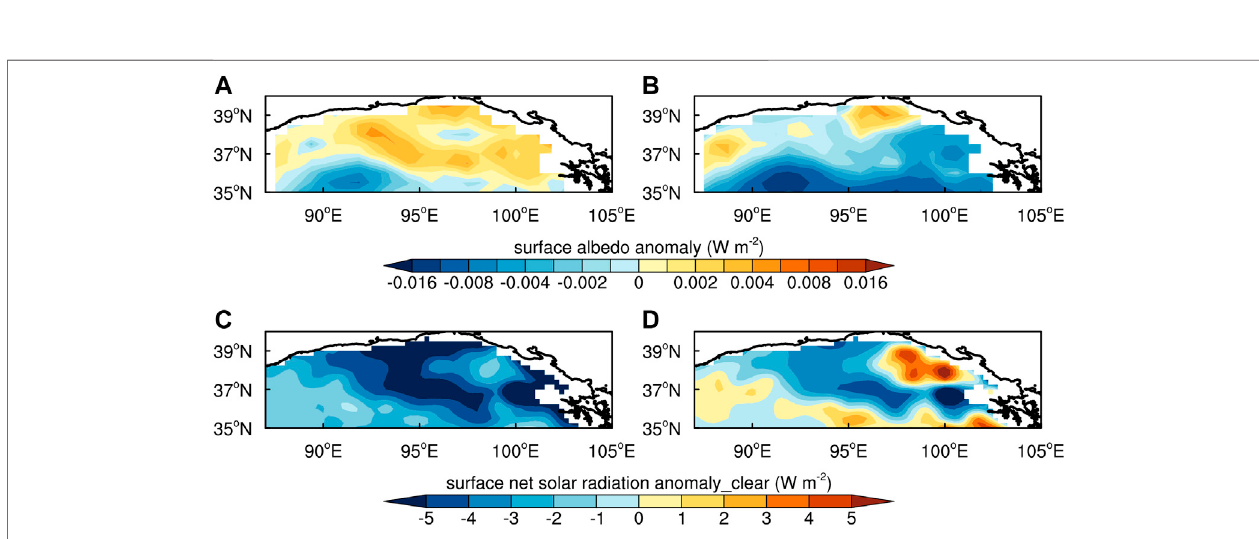
FIGURE 10 | Spatial distribution of (A,B) surface albedo and (C,D) surface net solar radiation (units: W m − 2 ) on ( fi rst column) the difference between high and normal days and (second column) the difference between low and normal days.